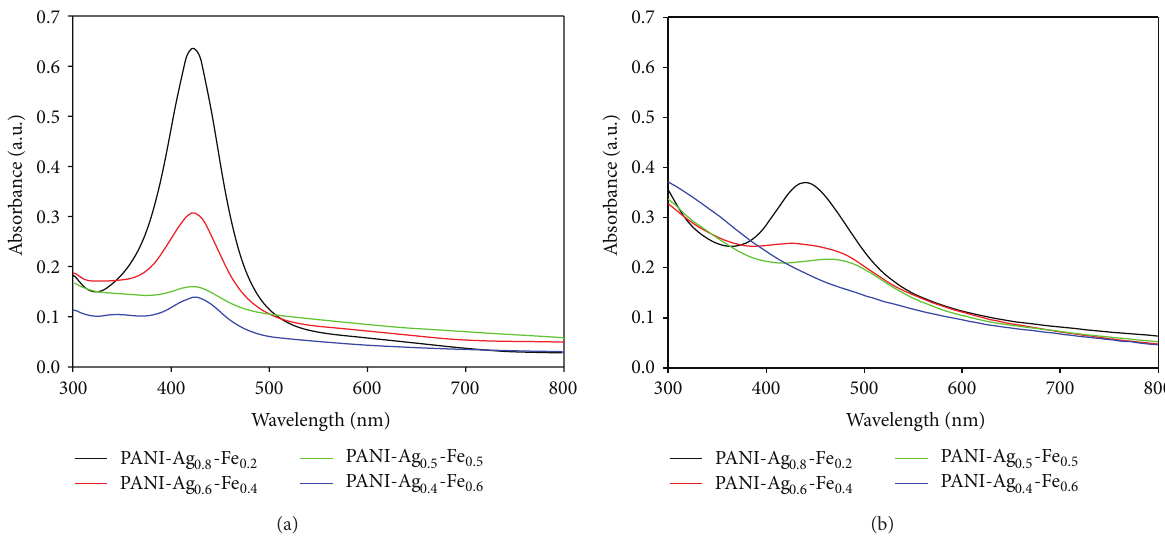
Figure 3: UV-Vis absorption bands of PANI-Ag-Fe nanocomposite thin films (a) before annealing and (b) after annealing.